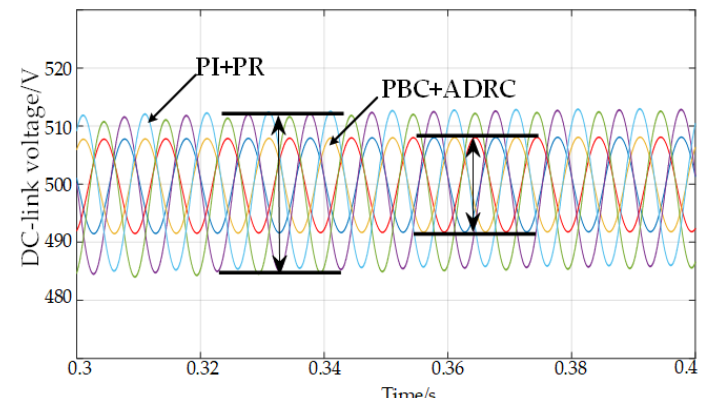
Figure 8. Control performance comparison of different control